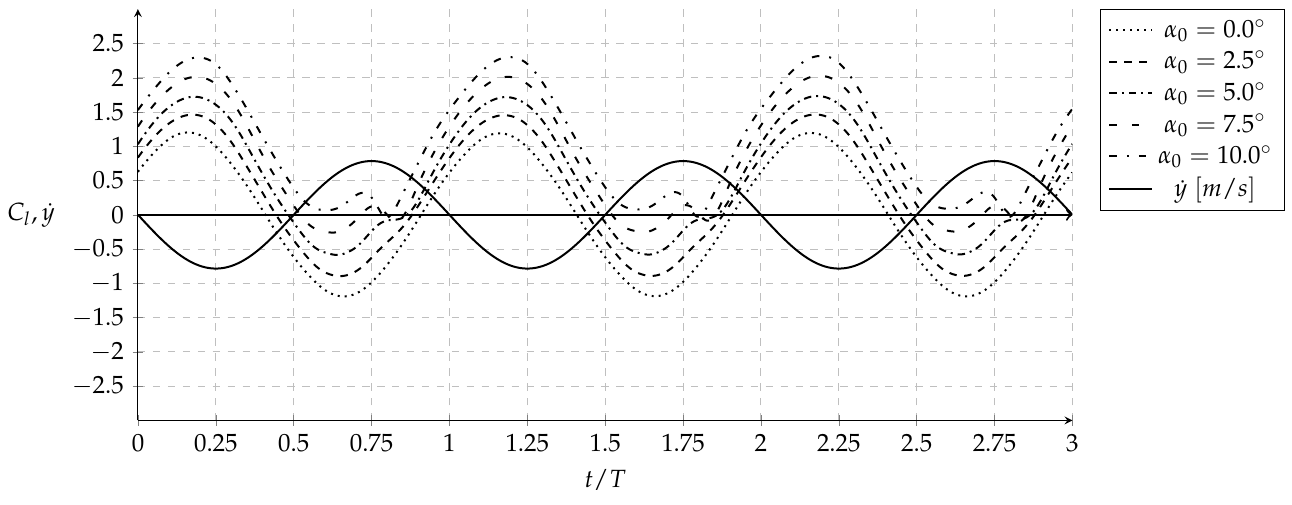
Figure 16. Lift coefficient as a function of t / T and α 0